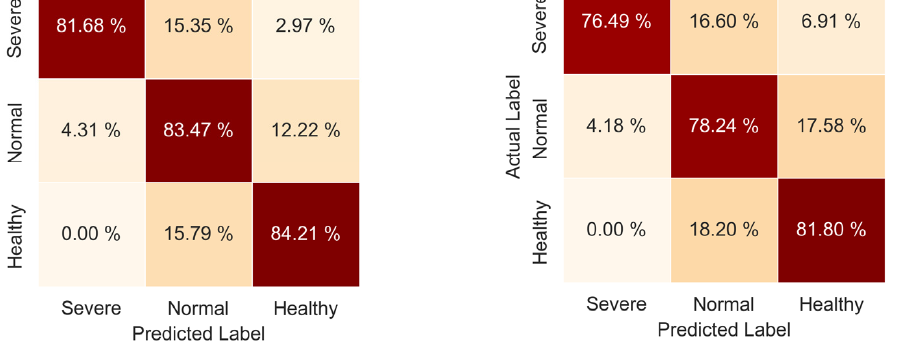
Table 2. Performance comparison between deep-learning models applied to hair follicle classifica- tion.